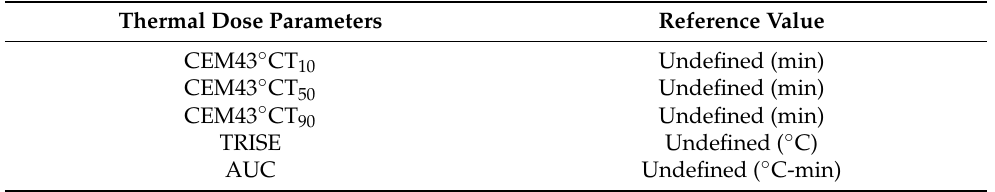
Table 4. Reference thermal dose parameters for